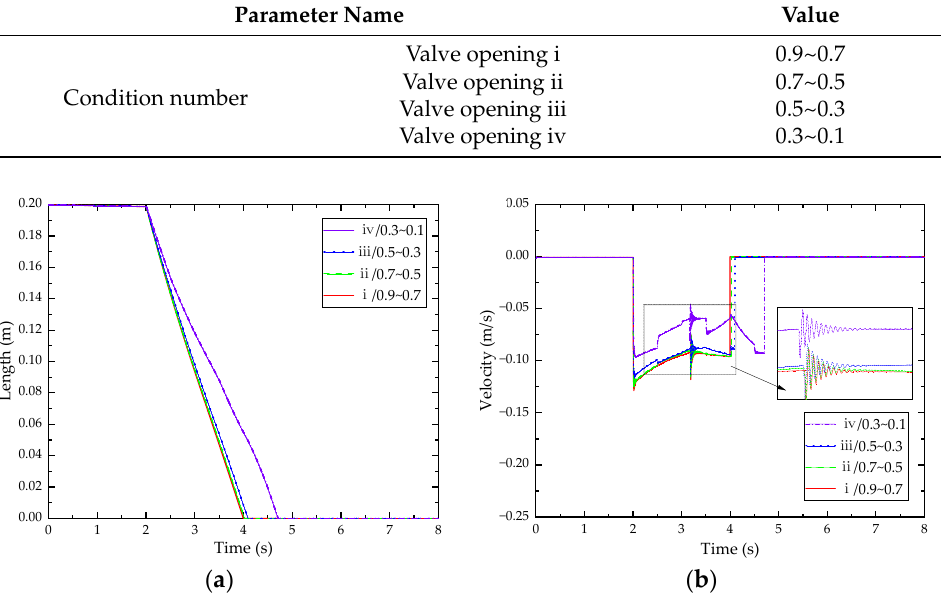
Figure 10. Effect of reversing valve spool stuck: ( a ) Piston displacement; ( b ) Piston Velocity. (6, 7) Actuator external leakage and internal leakage.